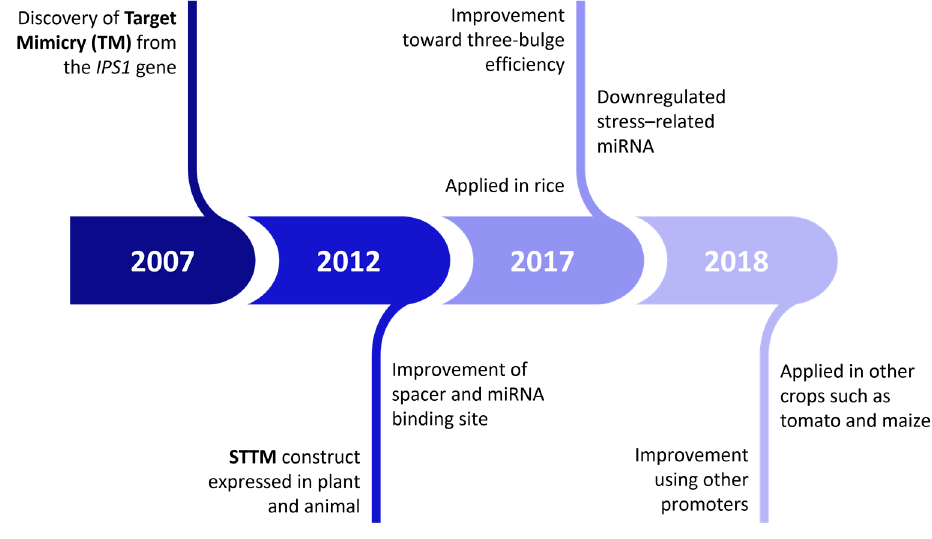
Figure 2. A historical timeline of the STTM approach developments that increased its efficiency and application in other plants.